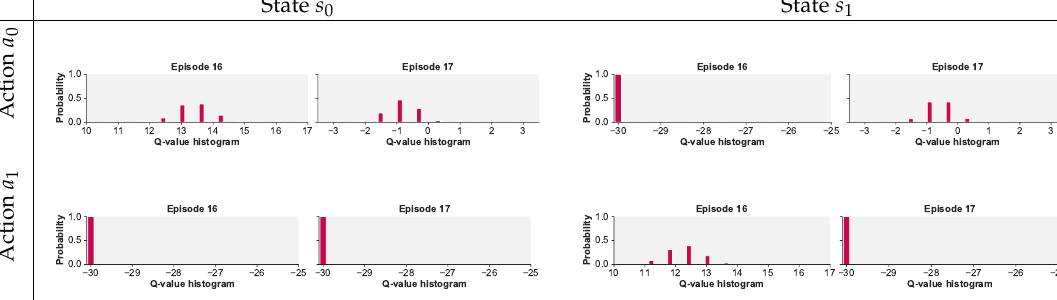
Figure 6. Q value histograms for (Categorical) disRL, leptokurtic case. Shown are distributions at the end of Episodes 16 and 17 in one particular game play. Game play is chosen to highlight the impact of tail risk on categorical disRL. The distributions for Episode 17 are obtained from those in Episode 16 plus 100 trials of disRL learning (without exploration). Note that the scale of the horizontal axes is not uniform across state-action pairs and